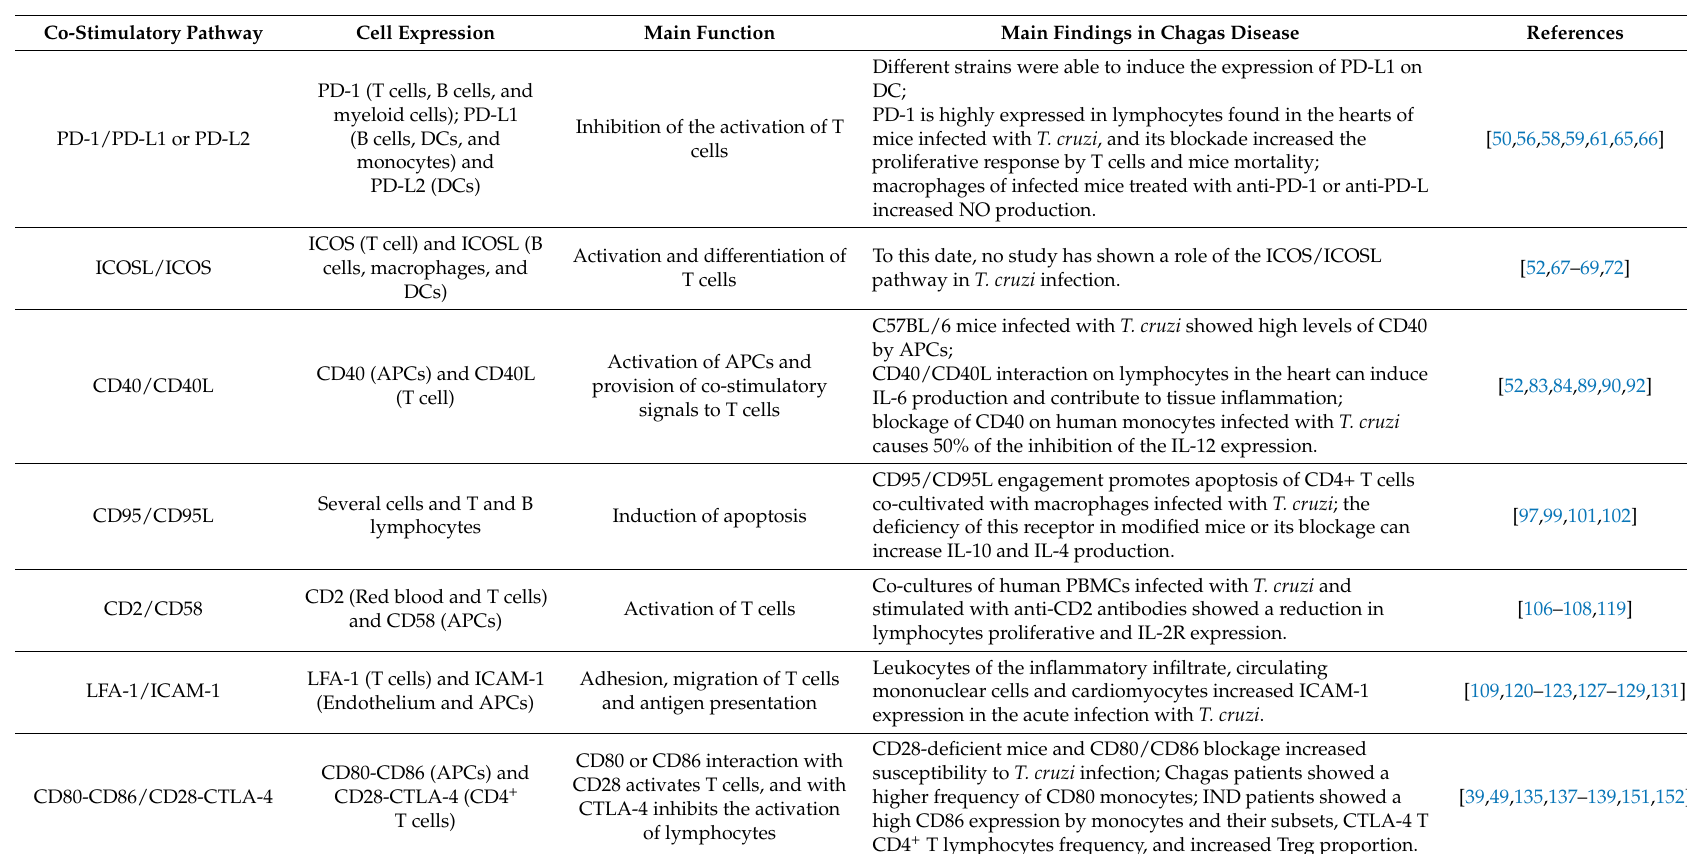
Table 1. The main co-stimulatory receptors and their possible roles in Chagas